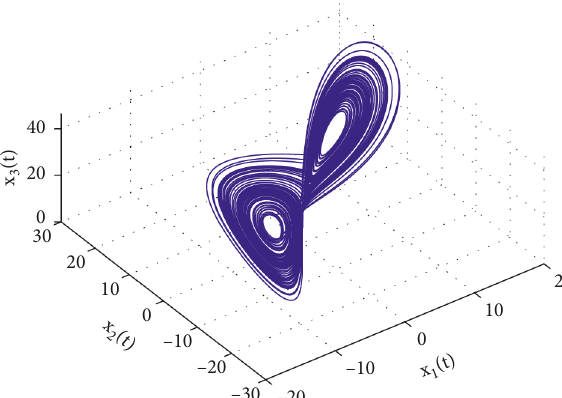
Figure 3: Trajectory of (77) with x ( 0 ) � [− 3 , 6 , 9 ] T for mode 3.